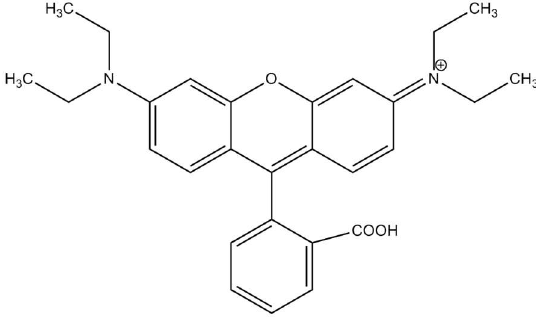
Figure 4. Rhodamine B. Figure 4. Rhodamine